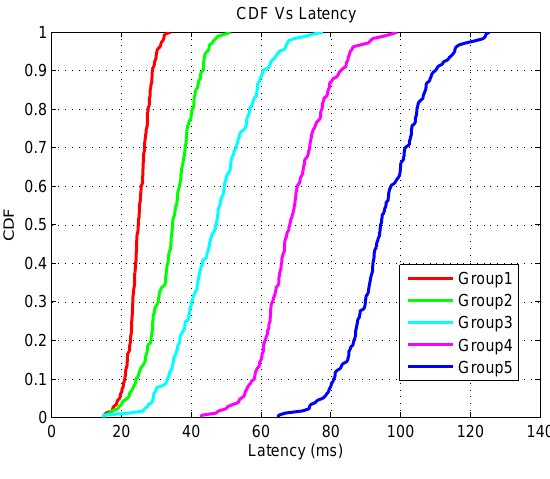
Figure 9. CDF Vs